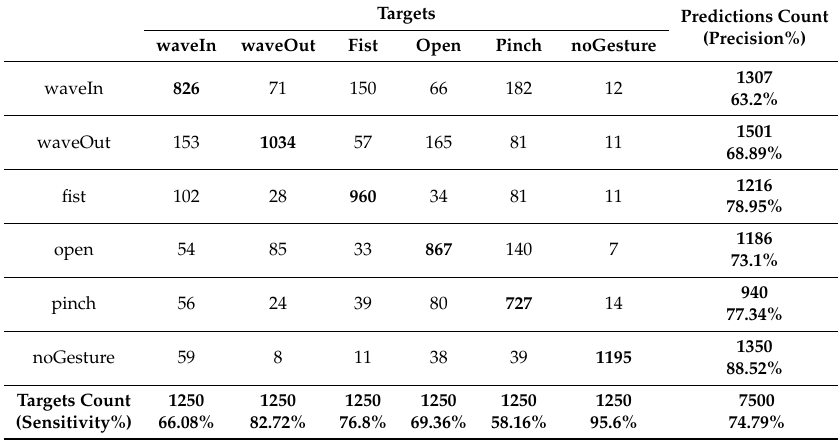
Table A6. Confusion matrix of open sync gesture for the user-general HGR